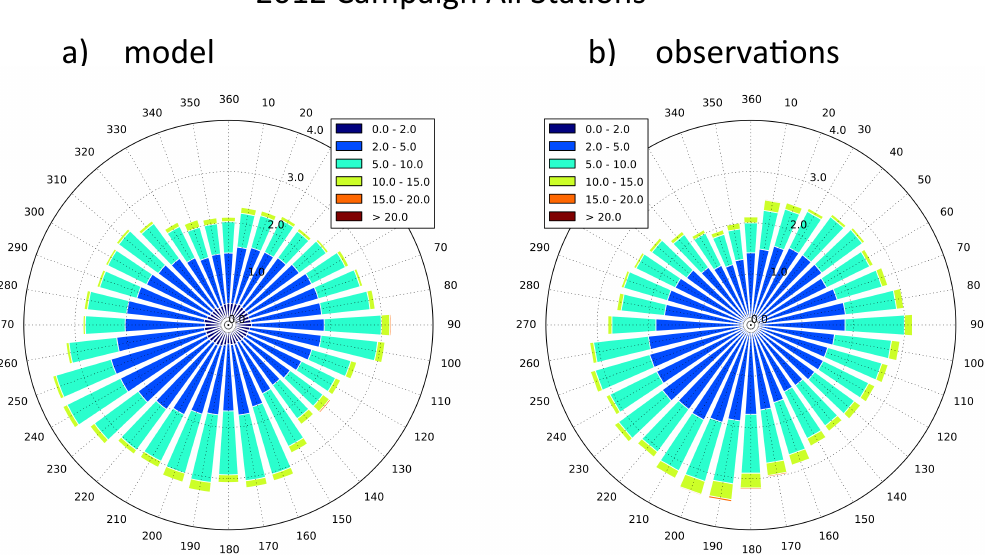
Figure 5. Wind roses for (a) model and (b) observations for the entire 2012 campaign. Model–observation pairs are retained only if the observed wind speed is ≥ 3kn. The unit of wind speed in these plots is ms − 1